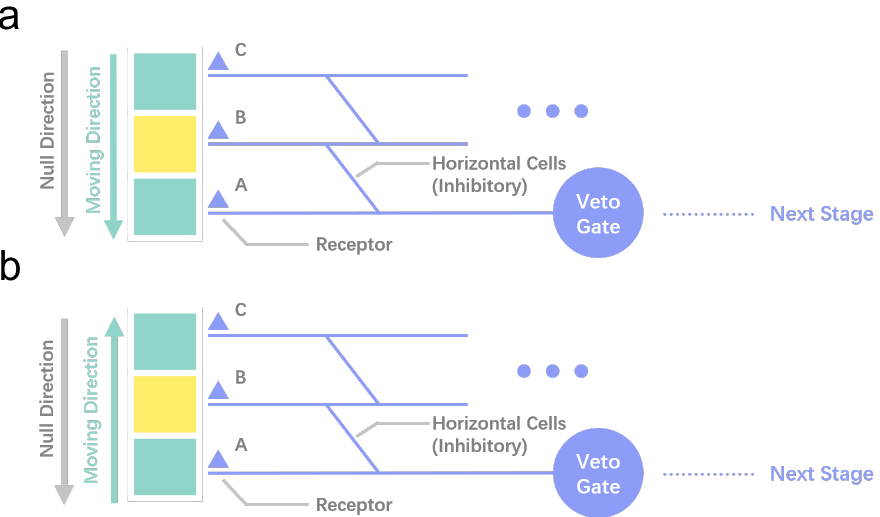
Figure 2. Local directionally detective neurons. In the left part of the pattern, a light spot (yellow) is traveling across the receptive field (blue). A, B and C are receptors. Response will be delayed when it passes horizontal cells. The veto gate offers Vote operations. ( a ) object moves in the null direction, ( b ) object moves in the preferred